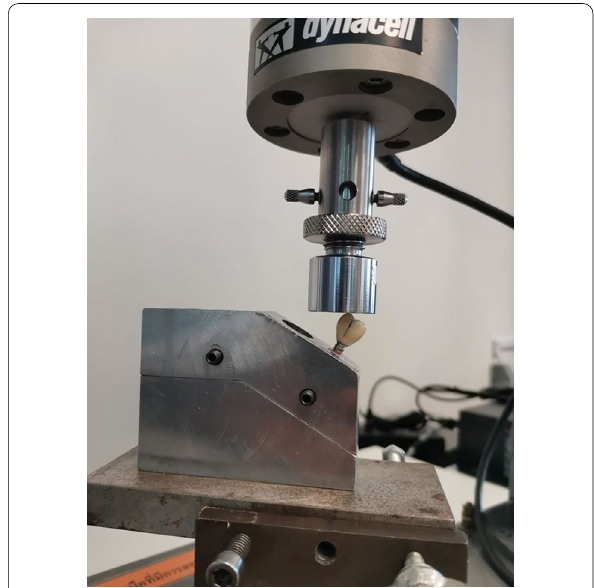
Fig. 3 Sample set at a 30-degree angle to the loading direction according to ISO